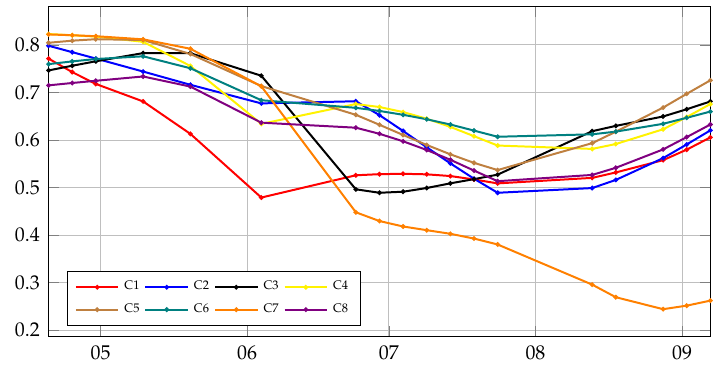
Figure 13. Mean NDVI temporal profiles of each cluster from the clustering into C = 8 clusters using multitemporal data. The x-axis is the month of year 2015, and the y-axis is the